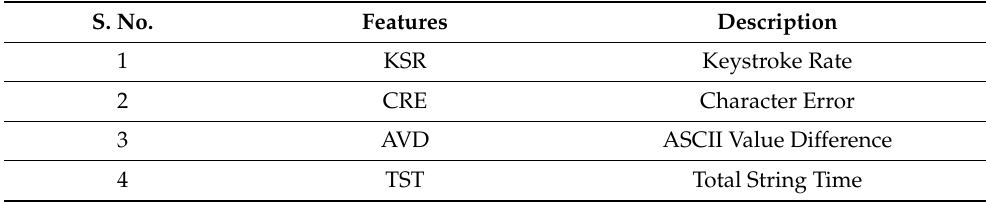
Table 3. List of features from keystroke